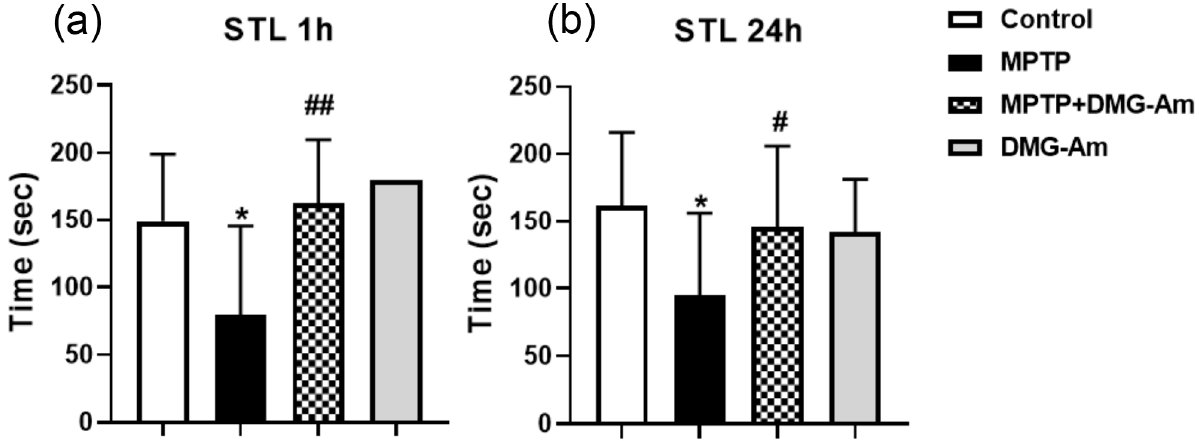
Figure 8. Effect of DMG-Am on step-through latency (STL) in the single-trial passive avoidance test in a mice model of PD: ( a ) STL time 1 h; and ( b ) STL time 24 h. Significance vs. control group: * p < 0.05; significance vs. MPTP-treated group # p < 0.05; ## p < 0.01. Statistical analysis was performed by one-way analysis of variance (ANOVA), followed by Dunnett’s post hoc comparison test.